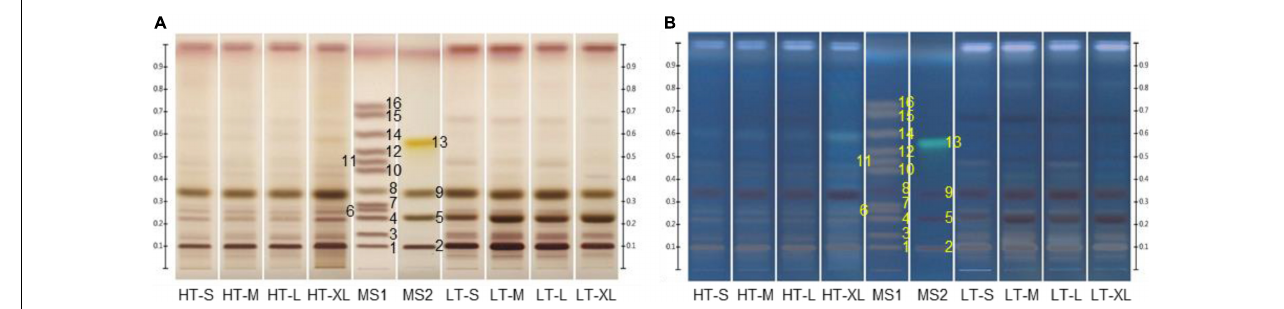
FIGURE 2 | Representative high-performance thin-layer chromatography (HPTLC) chromatograms of mixed standards and monk fruit samples. Plates were immersed into 10% sulfuric acid in ethanol solution for derivatization and photographed under (A) white light and (B) UV 366 nm. HT, monk fruit dried at high temperature; LT, monk fruit dried at low temperature; S, small; M, medium; L, large; XL, extra-large; MS1 and MS2, mixed standards. (1) Mogroside V (R f 0.10), (2) 11-oxo-mogroside V (R f 0.10), (3) isomogroside V (R f 0.15), (4) mogroside IV (R f 0.23), (5) sucrose (R f 0.23), (6) siamenoside I (R f 0.26), (7) mogroside IV A (R f 0.29), (8) glucose (R f 0.35), (9) fructose (R f 0.34), (10) mogroside III A1 (R f 0.44), (11) mogroside III E (R f 0.48), (12) mogroside III (R f 0.53), (13) grosvenorine (R f 0.56), (14) mogroside II A2 (R f 0.60), (15) mogroside II A1 (R f 0.69), and (16) mogroside II E (R f